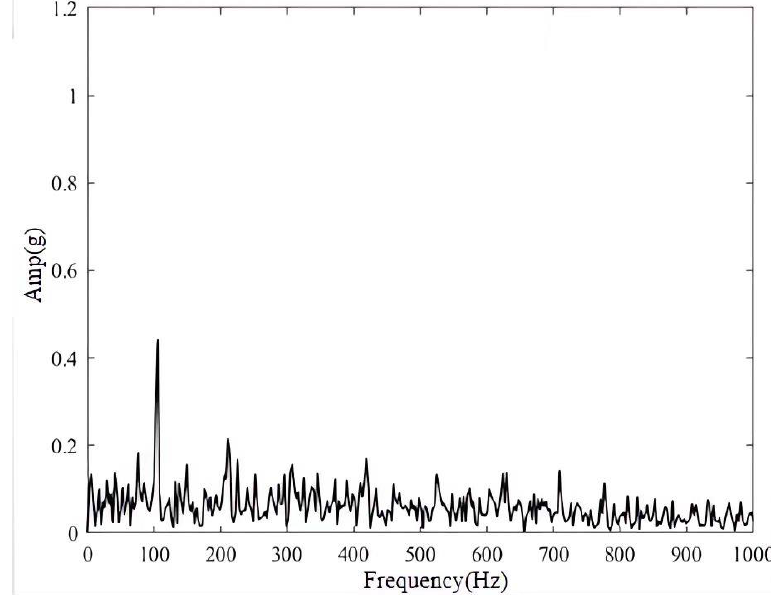
Figure 7. Fixed parameter VMD optimal component envelope spectrum.